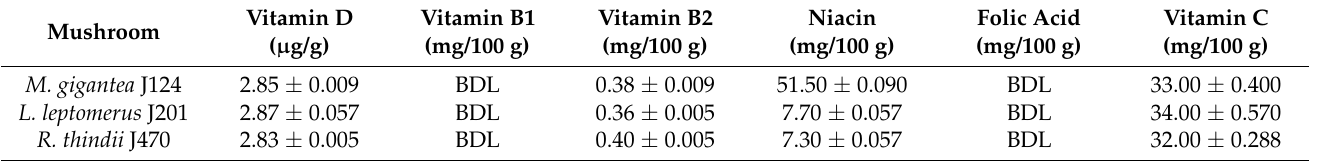
Table 2. Vitamin content of the three wild edible mushrooms mg/100 g dry weight.